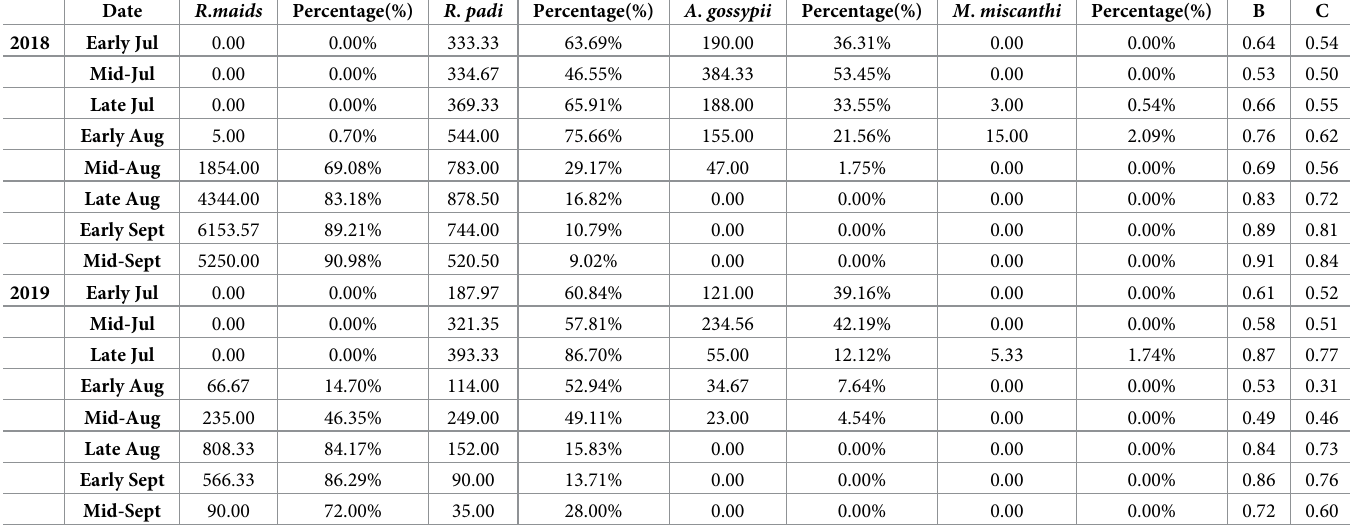
Table 1. The population dynamics and dominance of aphids in Changchun area